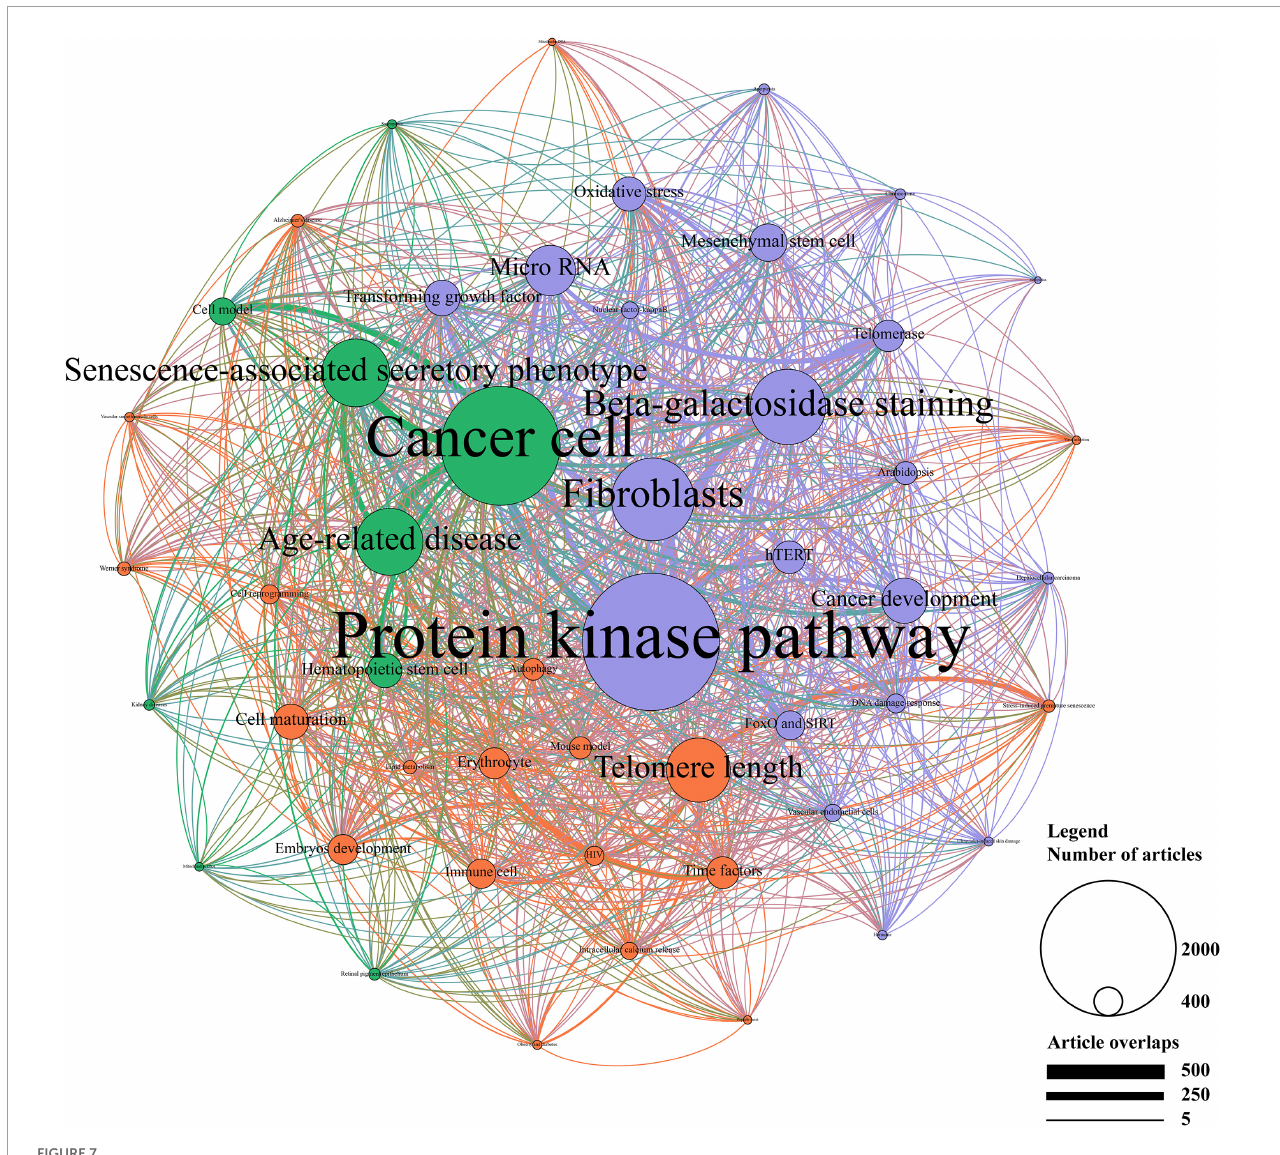
FIGURE7 Topic cluster network by latent Dirichlet allocation (LDA). The red cluster represents “physiological function”, the green cluster represents “pathological function”, and the blue cluster represents “molecular mechanism”. The size of the circle represents the number of publications in each topic, while the degree of line thickness represents the weight of connection between